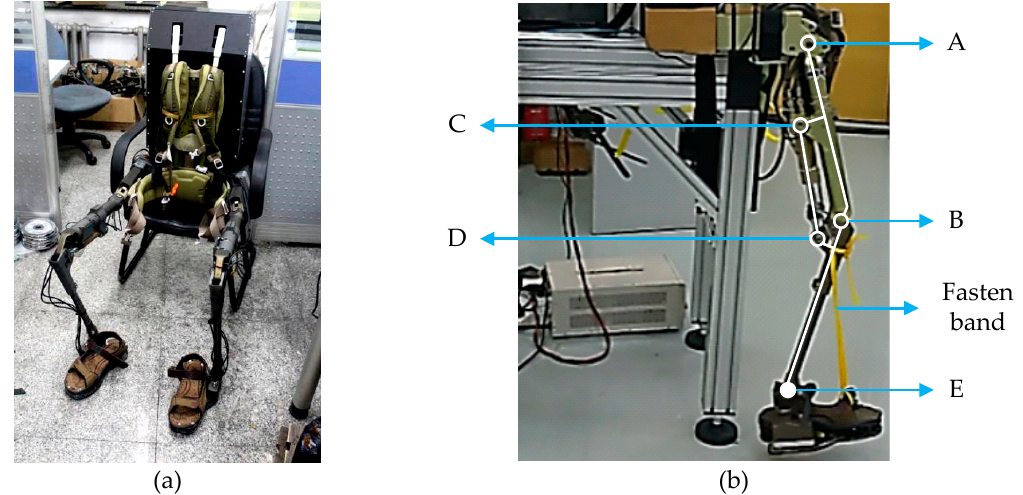
Figure 1. Active power-assist exoskeleton (APAL): ( a ) APAL; ( b ) Schematic diagram of APAL lower extremity mechanical structure.